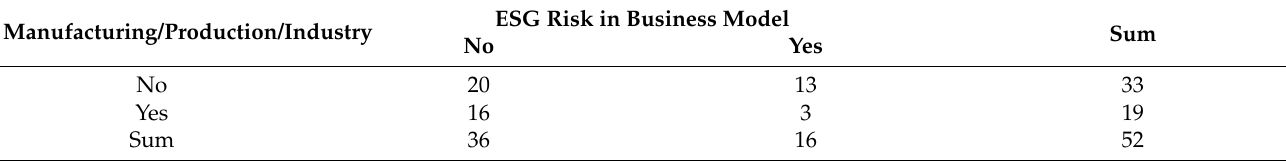
Table 15. Cross-way table for variables: Manufacturing/Production/Industry and ESG Risk in Business Model